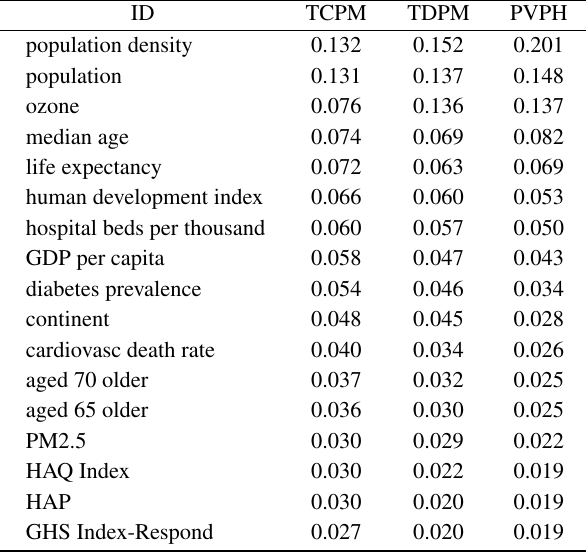
Table 2 Assessment of the contribution of features to the fitted values in the ERFR model.